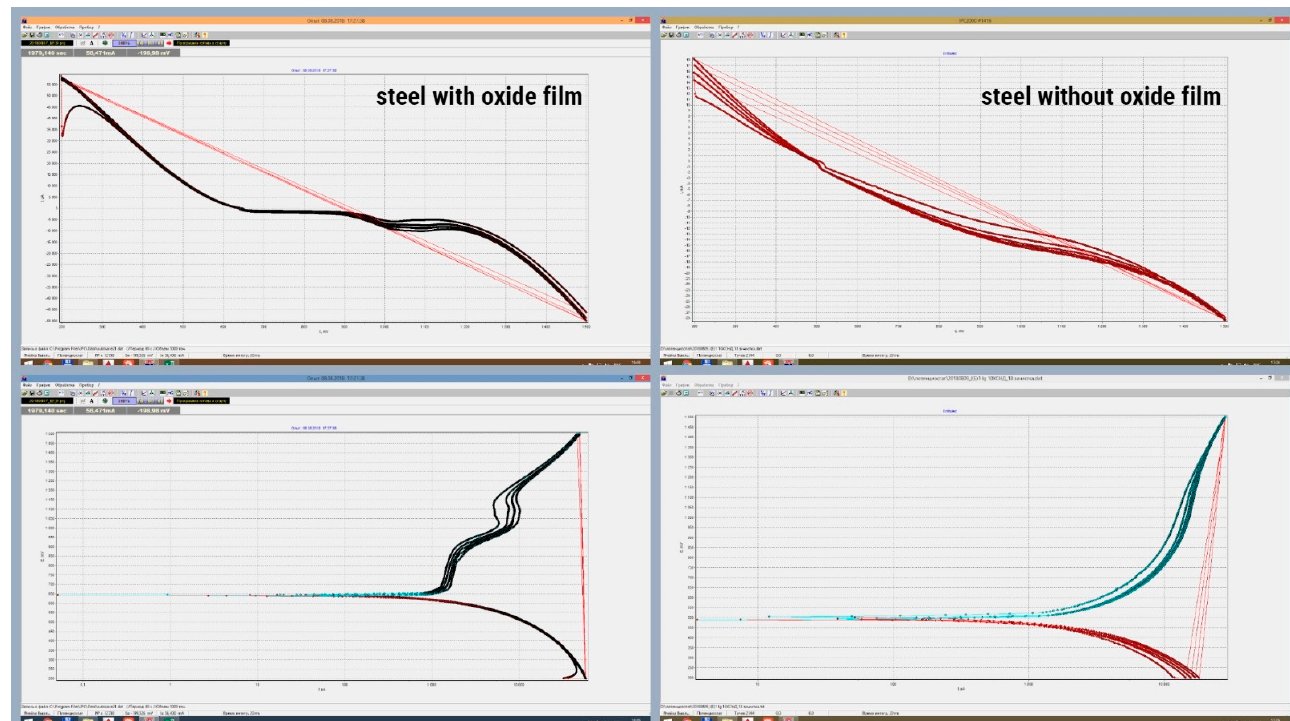
Figure 8. Experimental data.